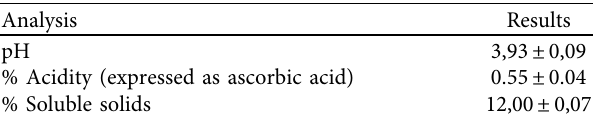
Table 3: Physico-chemical composition of the compote of nispero de palo ( Mespilus germanica L.) formulated with agar from Chondracanthus chamissoi